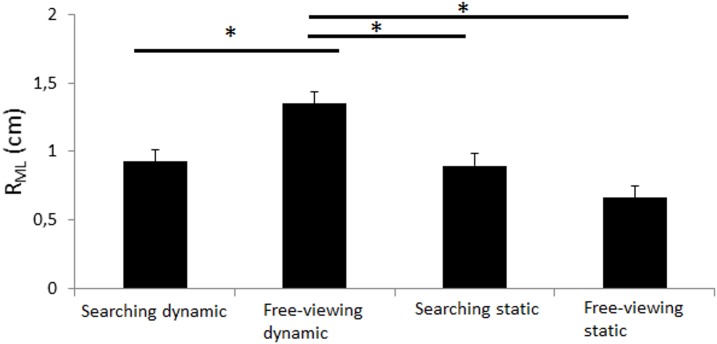
Range in medio-lateral.Range in medio-lateral (in cm) in both searching task (static and dynamic) and in both free-viewing task (static and dynamic). Vertical bars indicate the standard error. Horizontal bars indicate significant interactions.